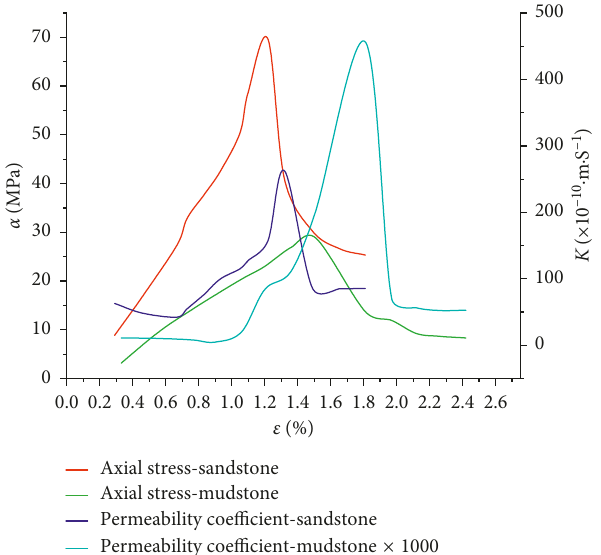
Figure 6: The relationship curve for the rock strength and per- meability coefficient with the strain of the fissure zone.